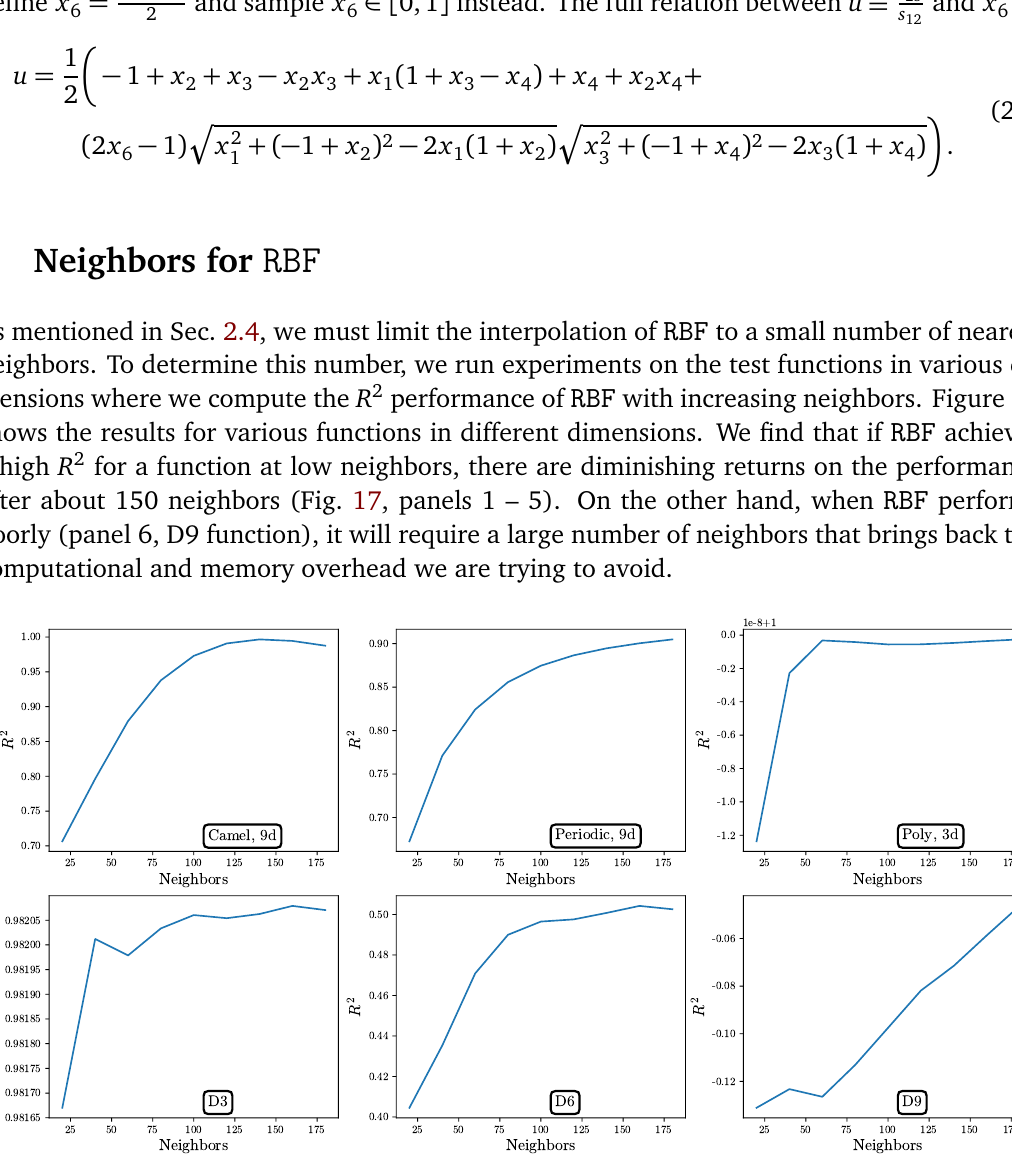
Figure 17: The performance metric R 2 of RBF as a function of the nearest neighbors for various functions and